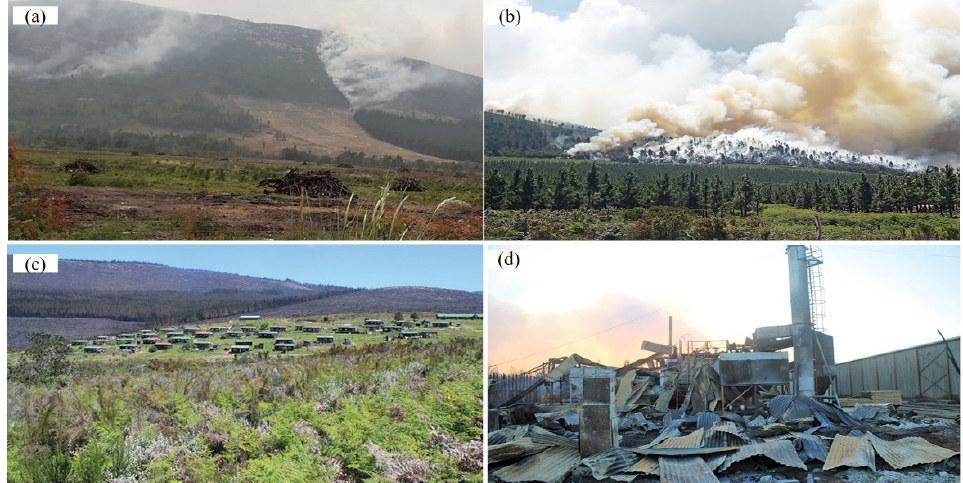
Figure 6. Burn severities in various terrain conditions; ( a ); Fire smoke recorded during fire event with young plantations in 2018 ( b ) Active fire plume; ( c ) Village adjacent to forest affected by fire; ( d ) Sawmill damaged by fire. (SA Forestry [26,27]).